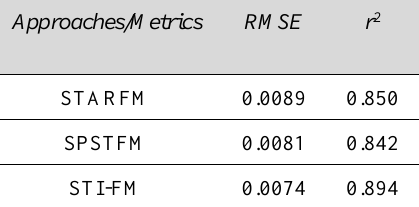
Figure 3. Comparison of the actual and synthetic Lnadsat-7 images in January 11, 2002 for the red band from STARFM (a), SPSTFM (b), and STI-FM (c). the black line represents the 1-to-1 fitting line.